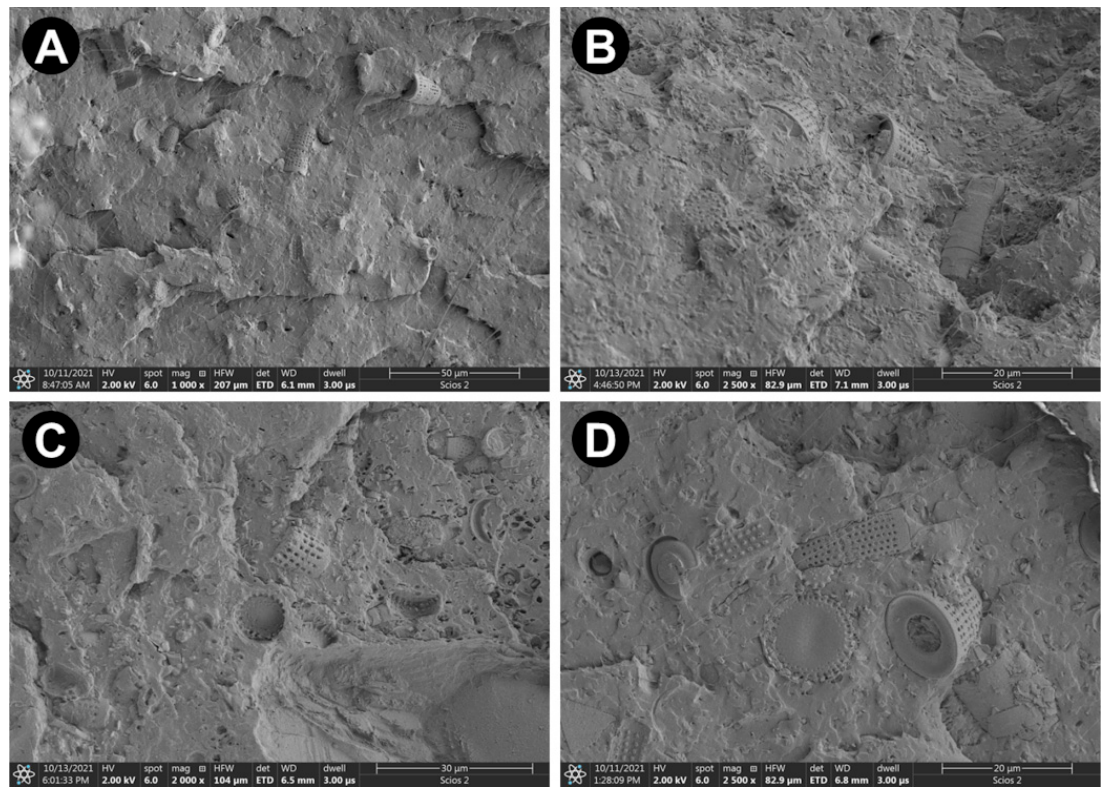
Figure 2. SEM images of the cross-sections of PLA-DE composites showing the uniform distribution of the reinforcement within the polymer matrix ( A ) 2003-5, ( B ) 3001-15, ( C ) 3251-10, ( D ) 4043-10. Results of the measurement of the density of manufactured composites are presented in Figure 3. The results obtained in the measurements of density clearly indicate a consid- erable porosity, which increases linearly with the content of DE.